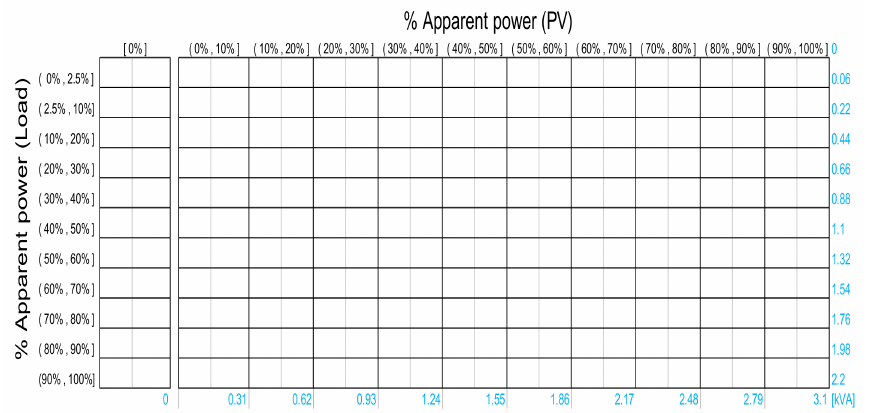
Figure 4. Scenario matrix with power demand and photovoltaic (PV) power injection intervals proposed by authors